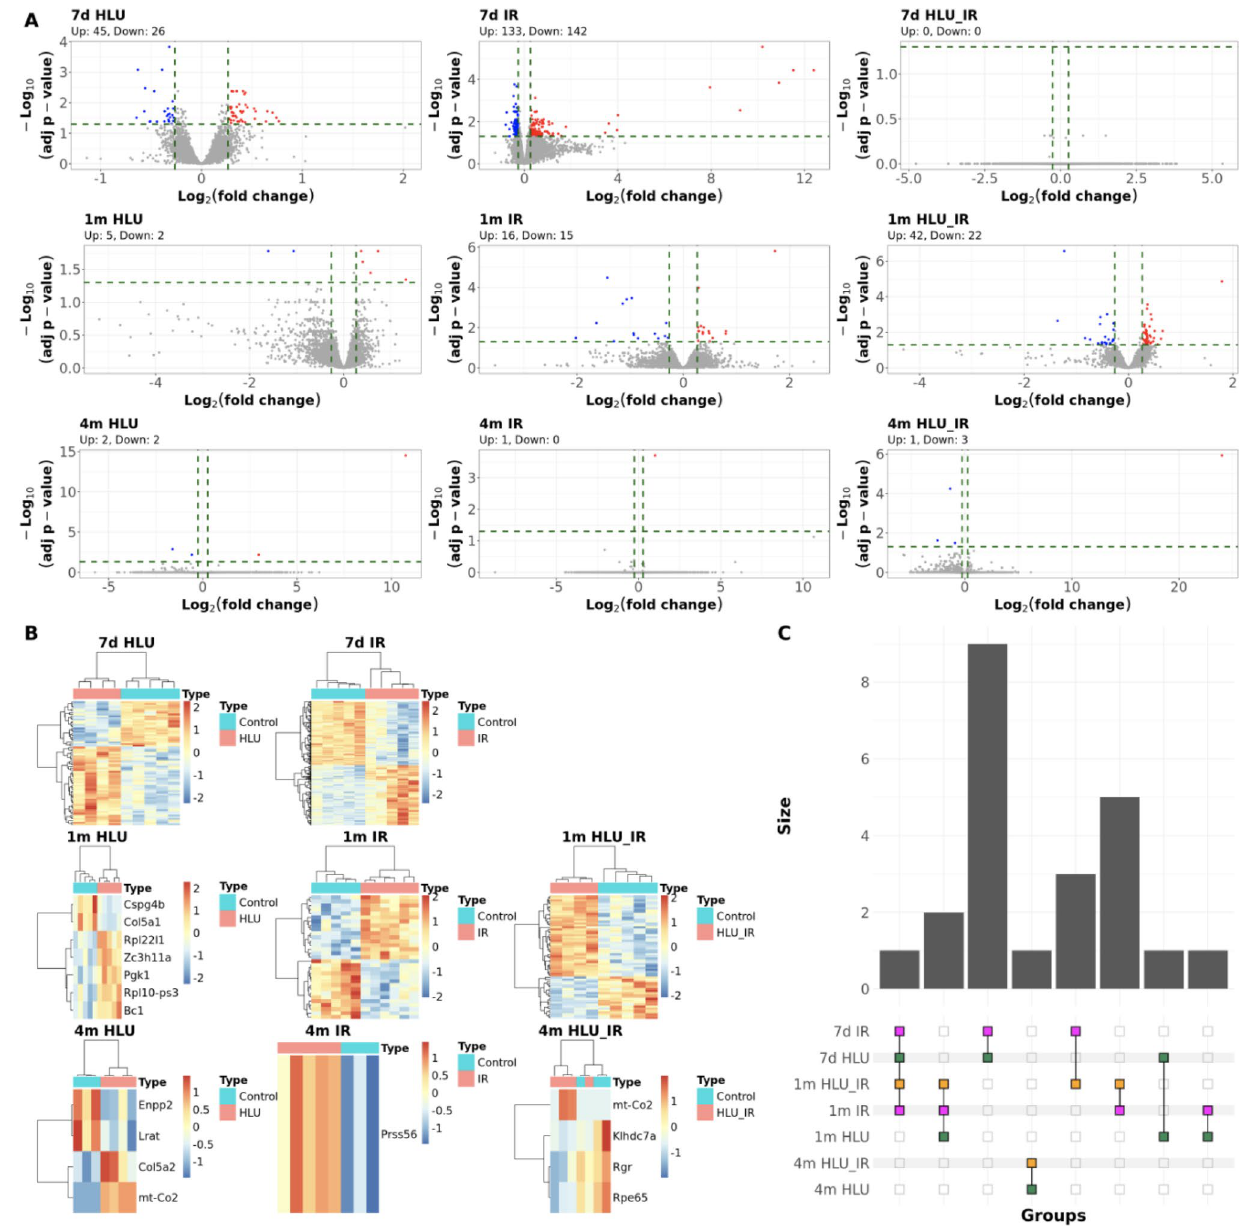
Figure 1. Differential gene expression in exposure groups. ( A ) Volcano plots showing DEG across each exposure condition (columns) at different time points (rows). Genes are colored by up-regulation (red) or down-regulation (blue) in exposed vs. control groups. Dashed green lines denote differential expression cutoffs of 0.05 and 0.263 for adjusted p -value and magnitude of log 2 (fold-change), respectively. Counts for up- and down-regulated genes in each exposure group are listed above each plot. (B) Heatmaps corresponding to the hierarchical clustering analysis of DEG in each group. Relative variance stabilizing transformed (VST) gene counts across samples are displayed as colors ranging from blue (low) to red (high) as shown in the key. Rows and columns are clustered using correlation distanceand correspond to genes and samples, respectively. Exposure or control status are shown with colored bars at the top of each heatmap. (C) Upset plot showing DEG shared between at least two of the nine groups. The Y-axis represents the number of genes in a given intersection set. The X-axis lists different intersection sets and is ordered by the number of intersecting groups in a given set. Dots are colored by exposure condition (magenta for IR, green for HLU, orange for combination). DESeq2 was used for differential gene expression analysis and R packages ggplot2 , pheatmap and ComplexUpset were used for visualization. DEG differentially expressed genes, HLU hindlimb unloading, IR